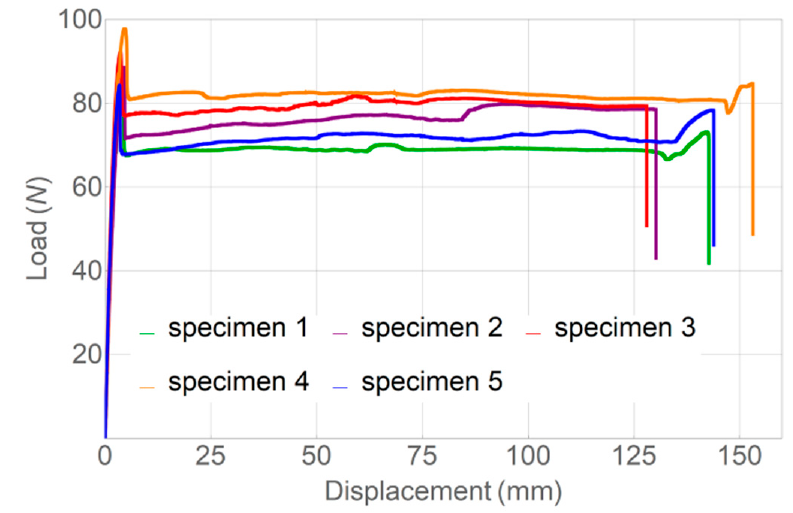
Figure 10. Stress–strain diagrams for as-delivered filament.